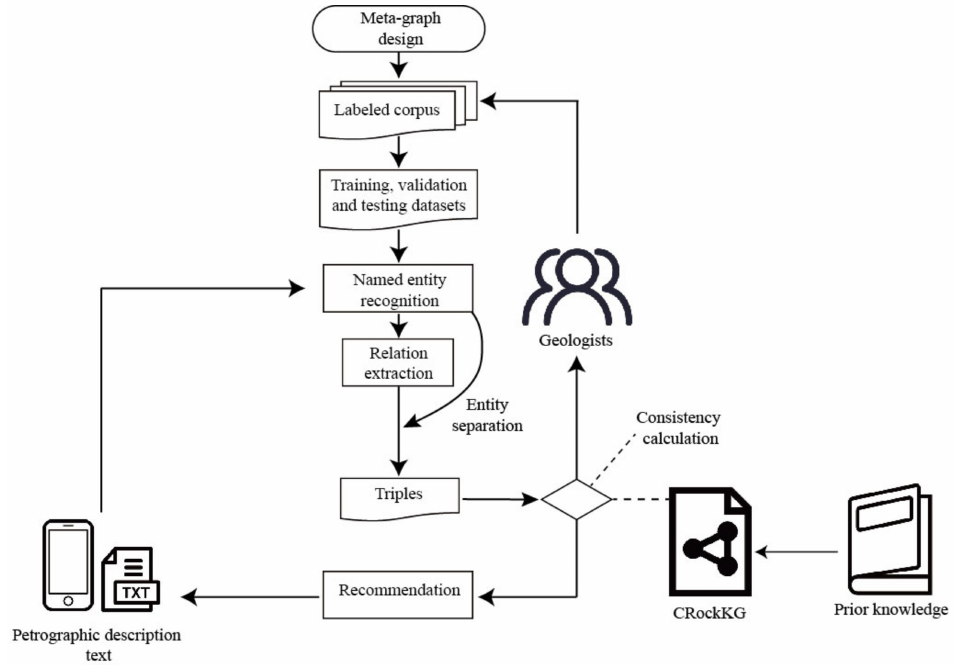
Figure 2. The framework for knowledge extraction and quality inspection of petrographic